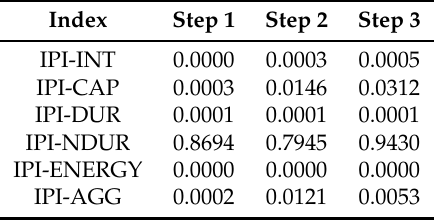
Table 25. Modified Diebold–Mariano statistics for the equality of forecast accuracy of two forecasts under general assumptions with an expanding window from 2015:01 to 2018:12. The null hypothesis is that the two methods have the same forecast accuracy. The loss function is the squared error.